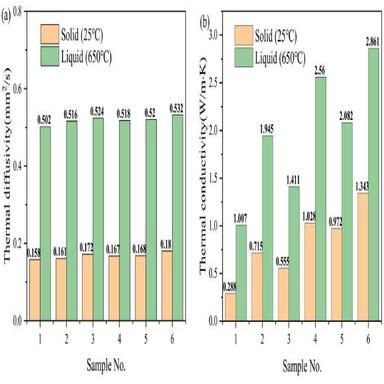
Thermal diffusivity (a) and thermal conductivity (b) of BS and CPCMs.